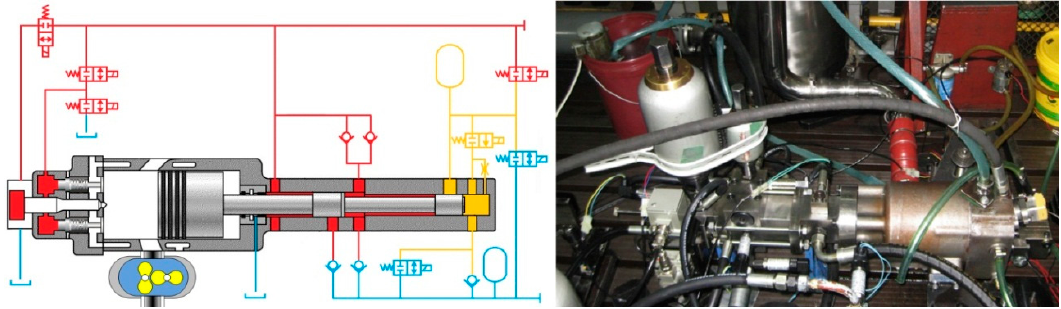
Figure 26. The HFPE of the Beijing Institute of Technology [68].